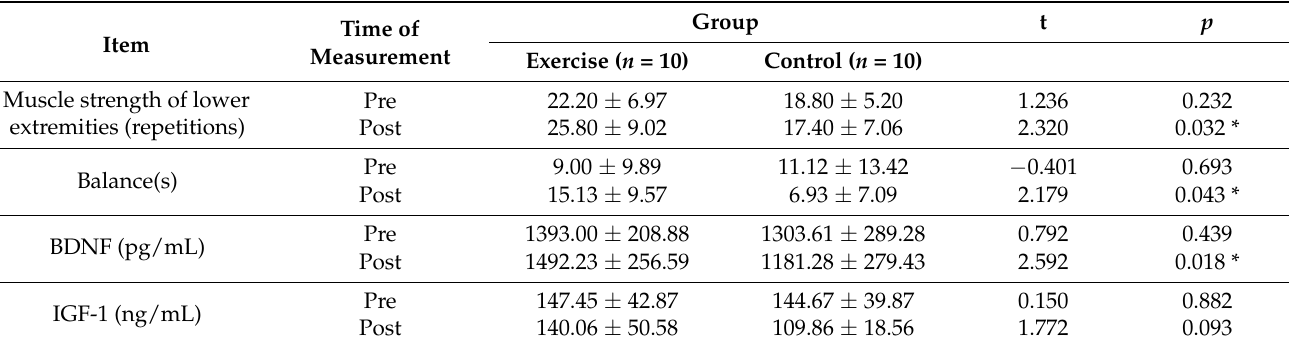
Table 5. Independent t -test